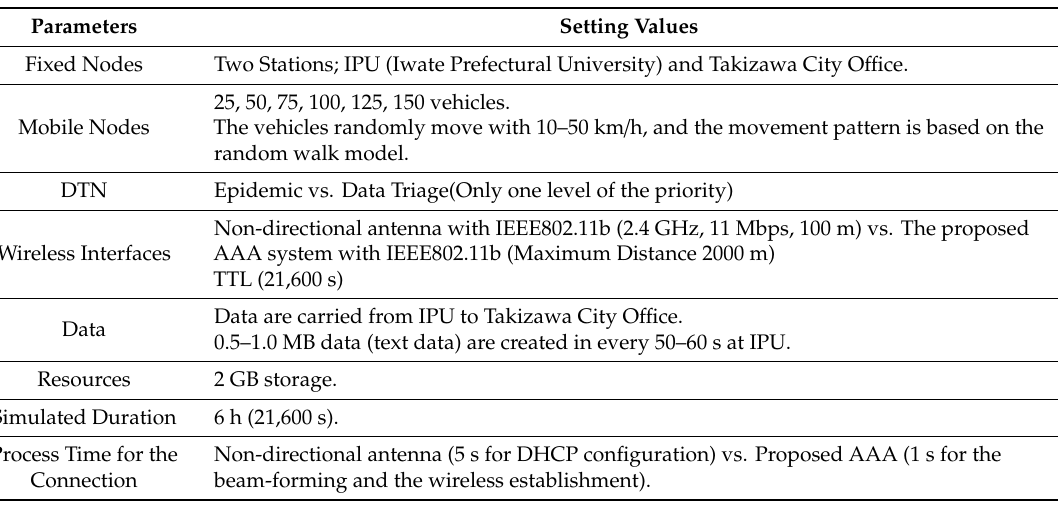
Table 2. The scenario of the network simulator in the experiment.